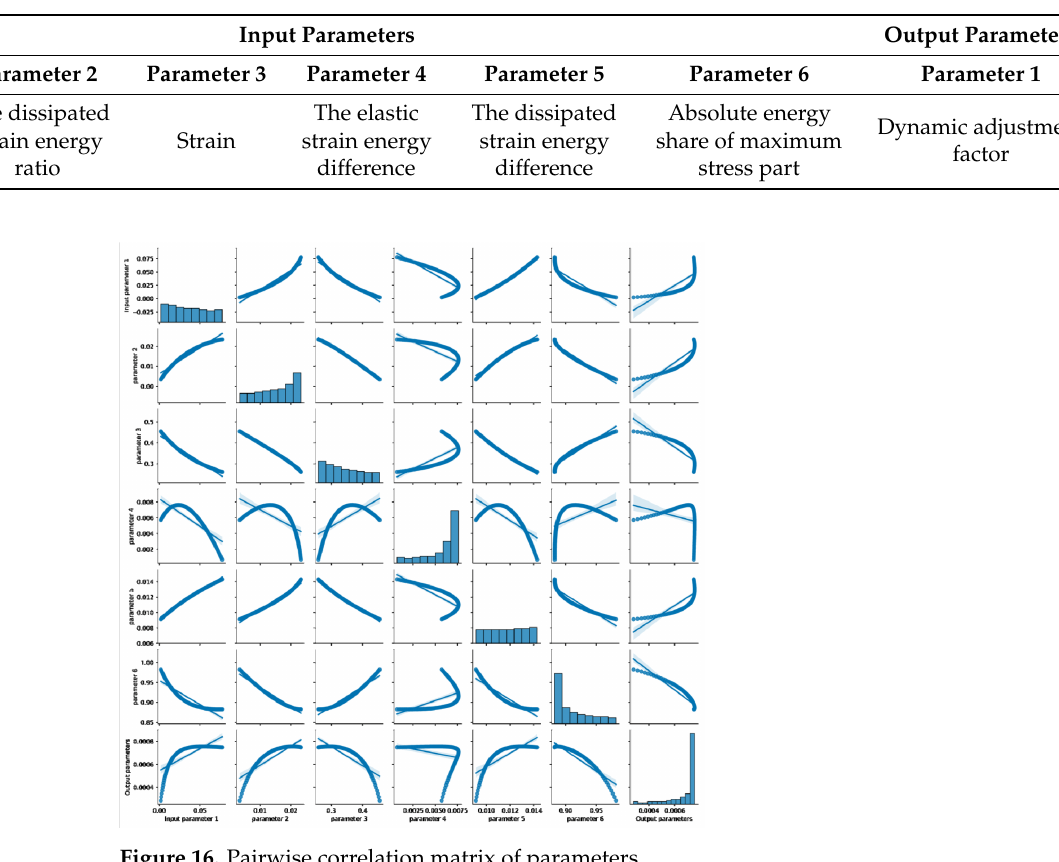
Figure 16. Pairwise correlation matrix of